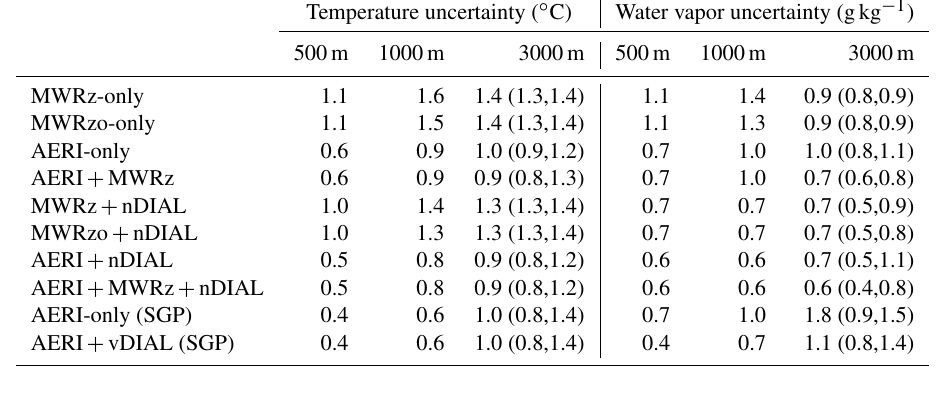
Table 2. Average uncertainty values (derived from S op ) at three levels for temperature and humidity for the different instrument combinations used in this study. The passive-only retrievals are highlighted in gray, whereas the active + passive are in white. The values in parentheses at 3km show the 10th and 90th percentile at that height, thereby providing a measure of the amount of variability in these statistics for each retrieval.